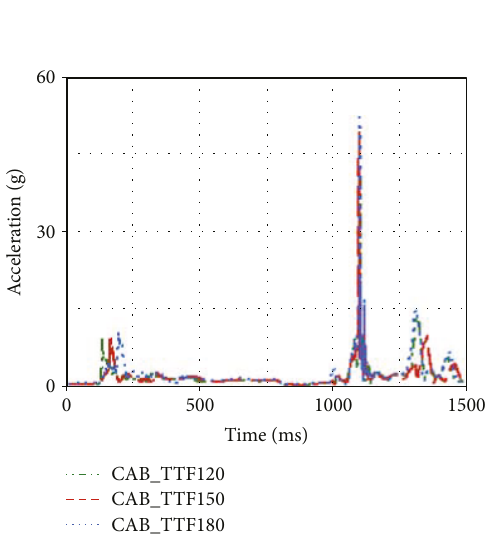
Figure 14: Head accelerations of di ff erent TTFs.